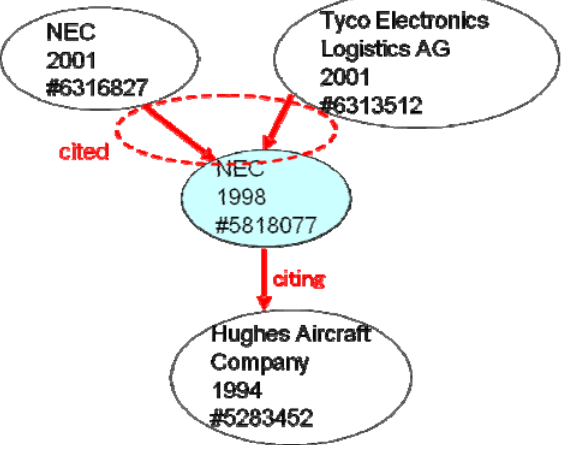
Source: Created by the authors based on data from the